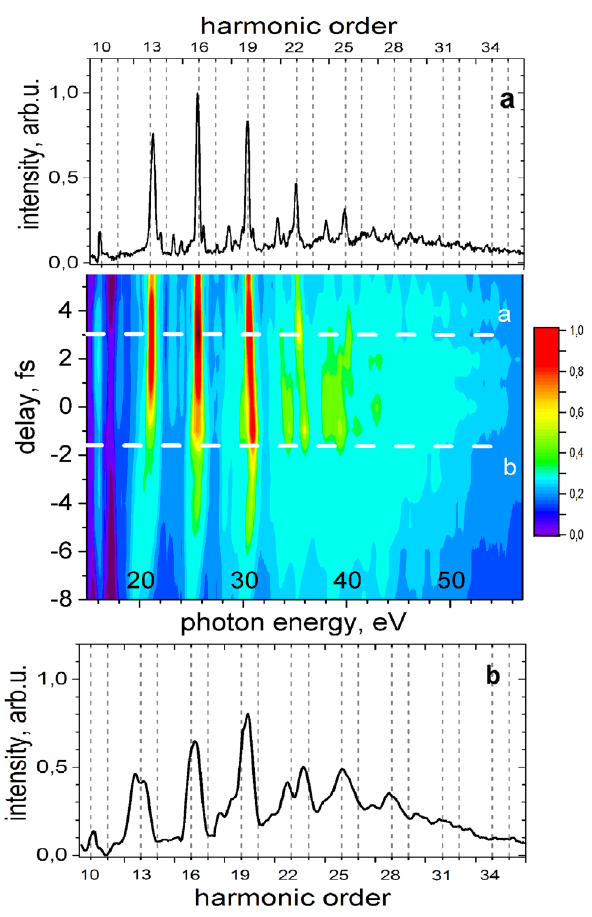
Figure 2. Spectrum of high harmonics generated in two-colour bi-circular approach with few-cycle pulses. The 2D-color figure present the spectra for different time delays between fundamental and second harmonic driving fields, the upper (a) and lower (b) panels present the harmonics spectra for time delays +3 fs and −1.8